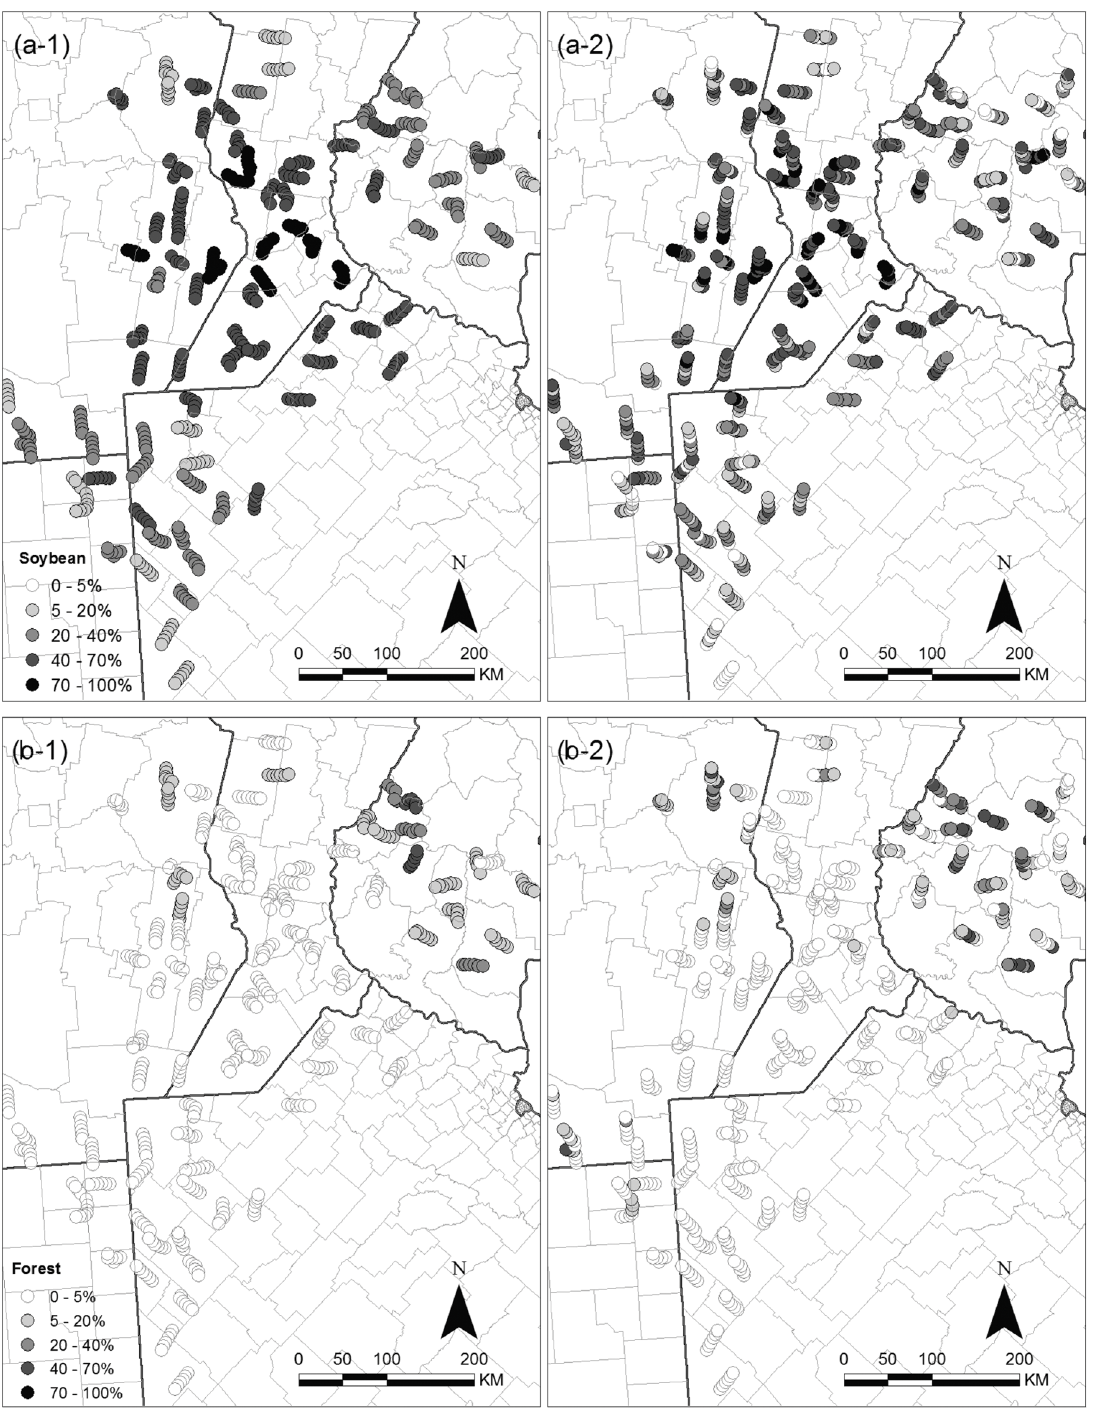
Fig 2. Land use and land cover proportion in the area of regional bird monitoring program in Pampas and Espinal ecoregions in Argentina. Land use of (a) soybean and land cover of (b) native forests for (1) 2006 and (2) 2012 is represented in percentage coverage in each site.